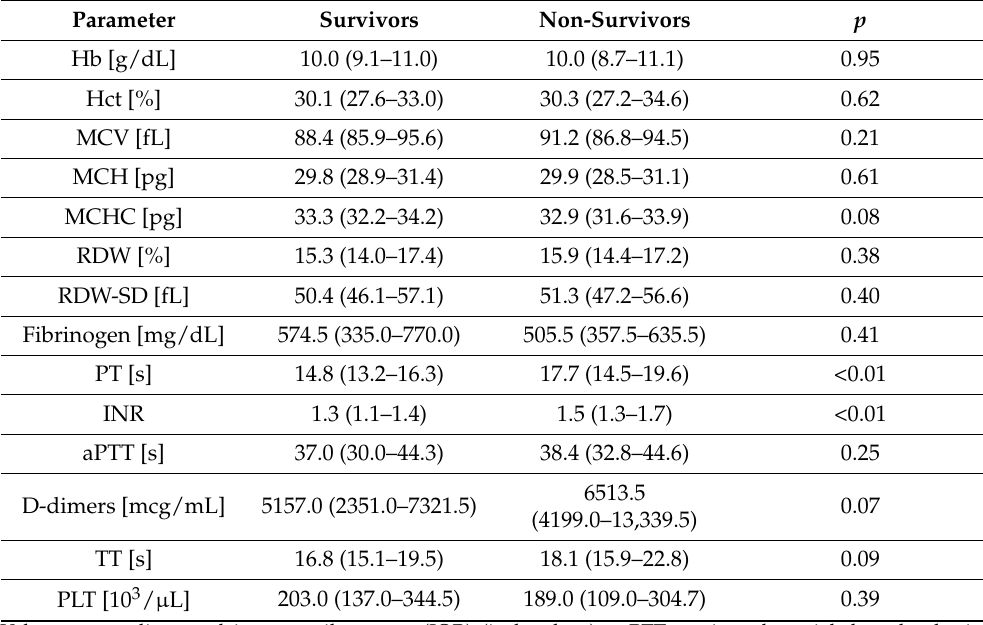
Table 4. Red blood cell indices and standard laboratory tests of coagulation in survivors and non- survivors with sepsis or septic shock.